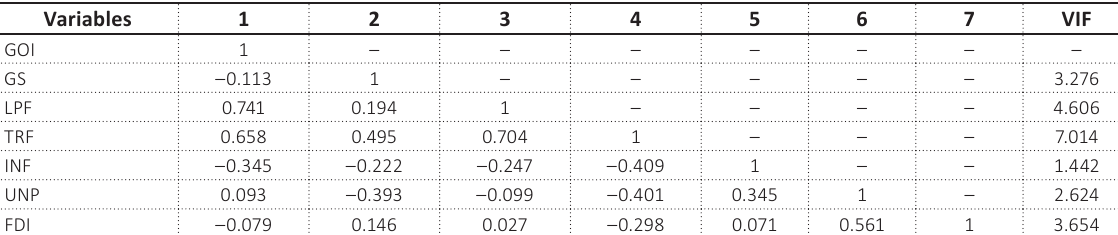
Table 4. Correlation and VIF results of sub-Saharan countries